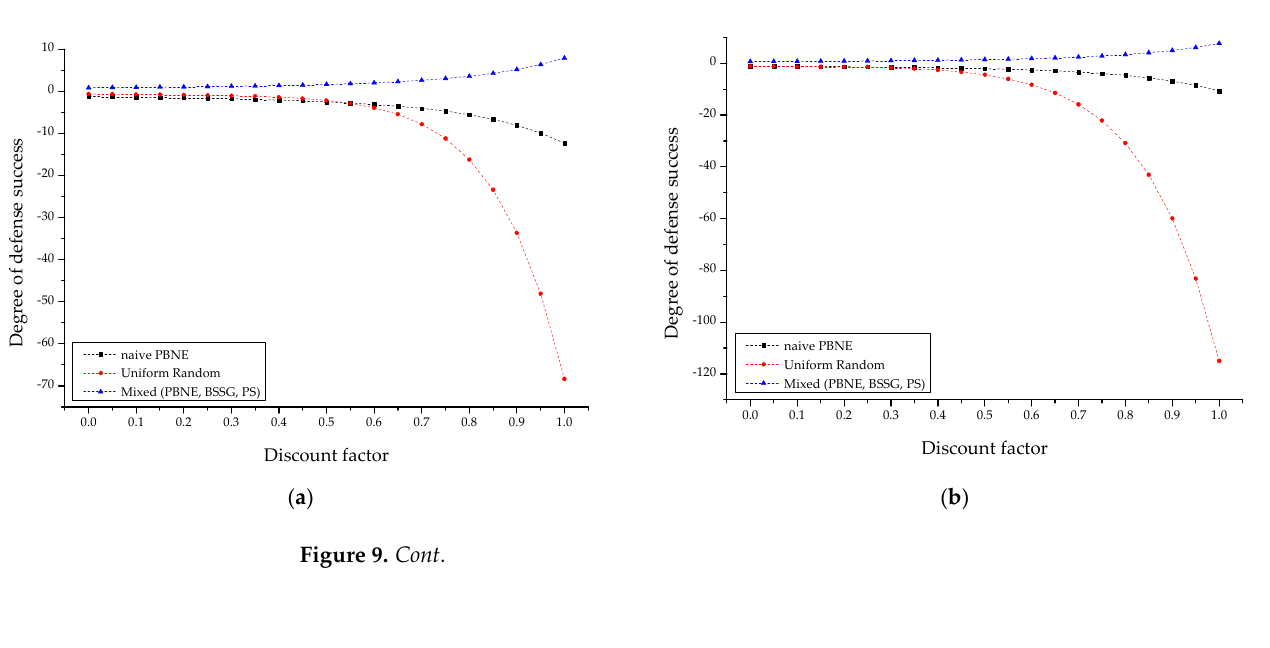
Figure 8. Comparison of the attack success probability in each state with Scenario 1. ( a ) S 0 , ( b ) S 1 , ( c ) S 2 , and ( d ) S 3 .